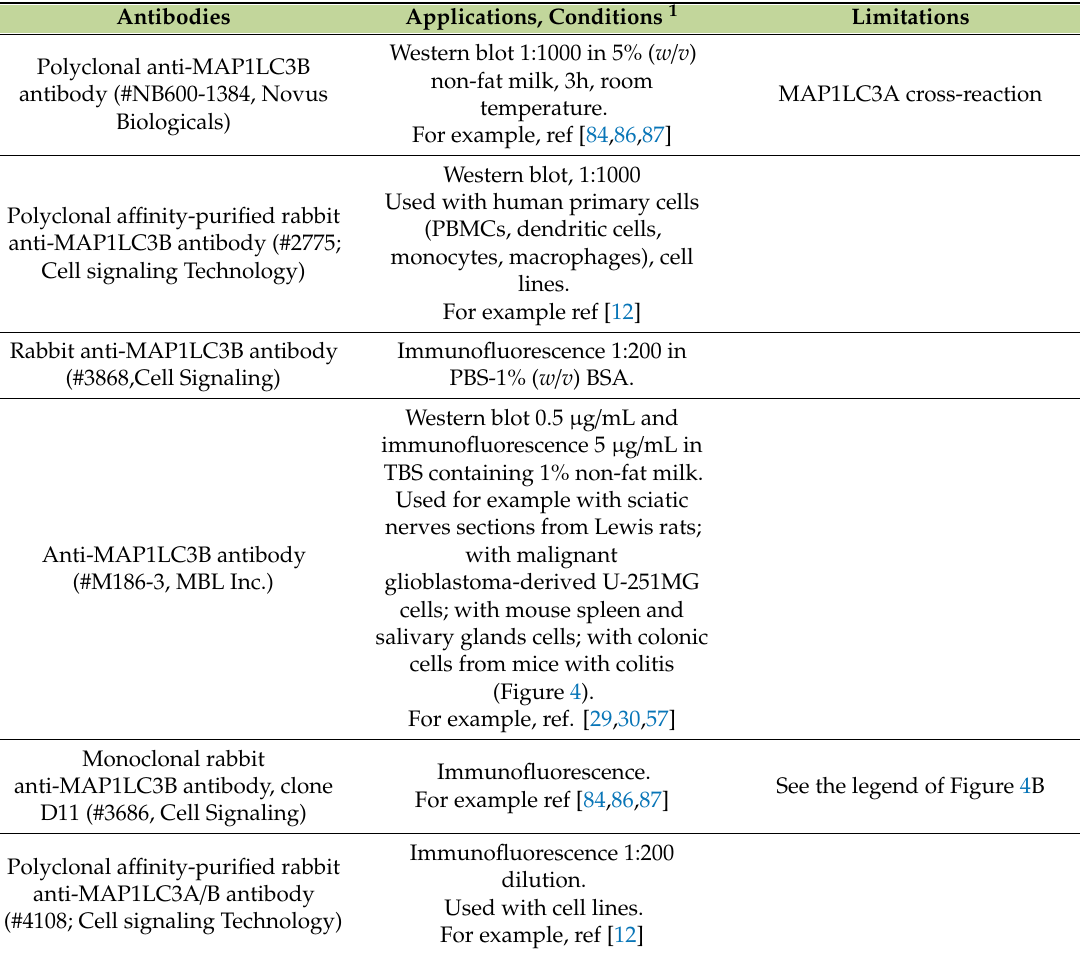
Table 4. Non-exhaustive list of MAP1LC3